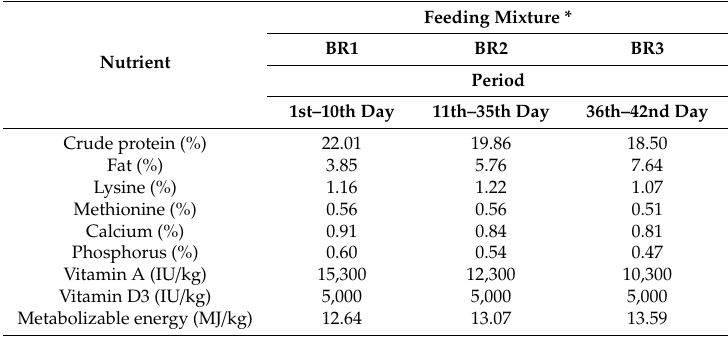
Table 2. The content of nutrients in feeding mixtures for broilers (BR1, BR2, BR3) in di ff erent periods of the